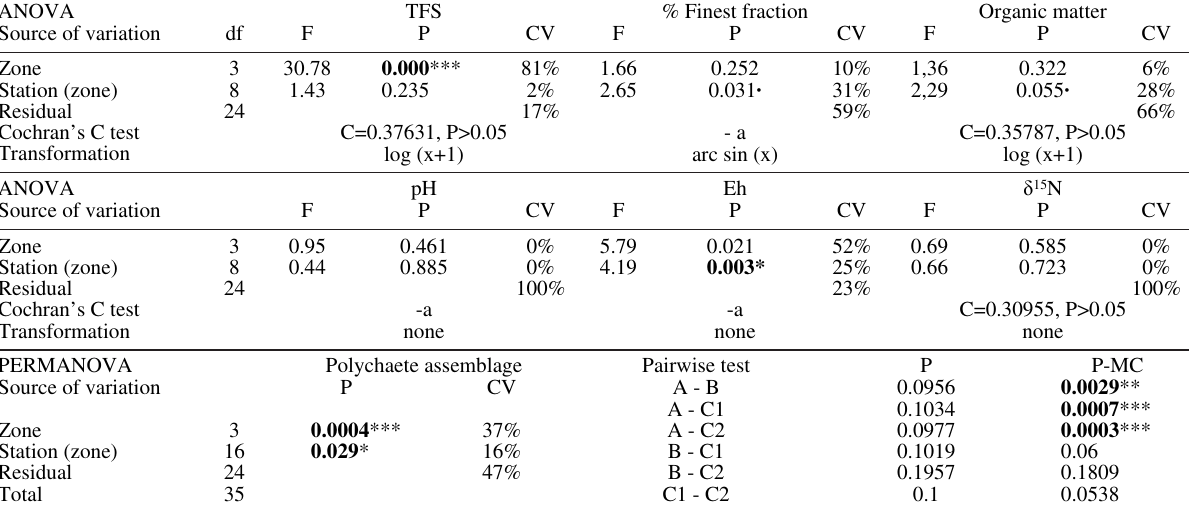
Table 2. – Results of ANOVA, PERMANOVA and pairwise test with two factors. Df, degrees of freedom; MS, mean square; F, F-distribution; MC, Monte Carlo test. Levels of significance: *p<0.05, **p<0.01 and ***p<0.001. -a indicates that there was no homogeneity of variance;